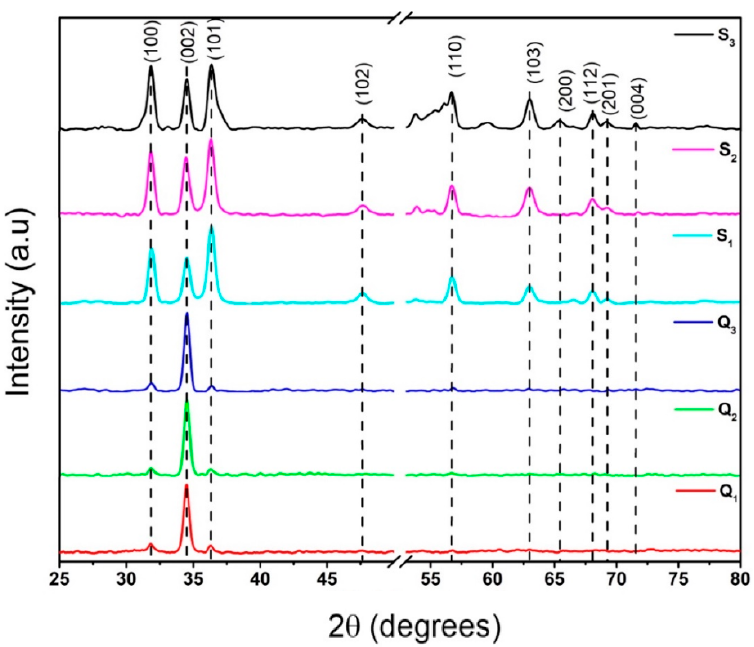
Figure 2. XRD patterns of the ZnO films—supported on quartz (Q 1 –Q 3 ) and Si (S 1 –S 3 ) substrates— obtained through the sublimation of ZnO from the ZnO/Zn precursor films at different temperatures.